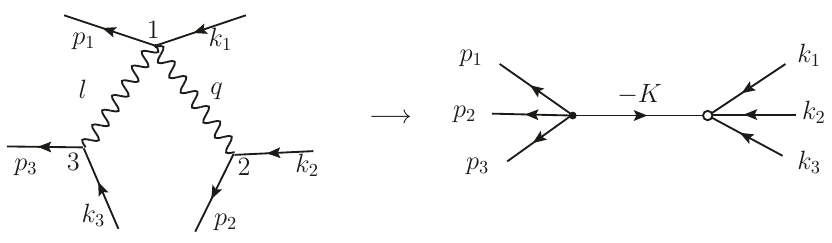
Figure 16 . The rule to replace a quartic vertex with two vector lines with the corresponding (cid:18) -graph. Here K = k 1 + k 2 + k 3